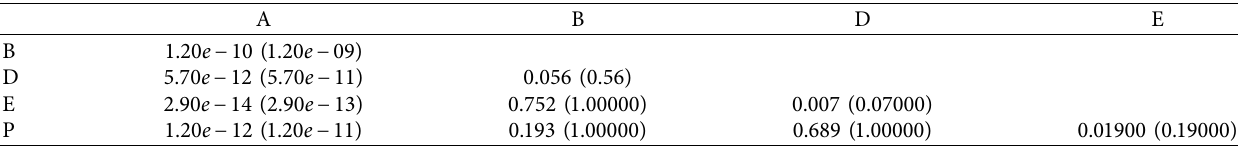
Table 11: In L-Space, for STAR network, pI � 0.05, pR � 0.0025, and T � 65, p -value of the Wilcoxon rank sum test (resultant p -value per Bonferroni correction is indicated in brackets).